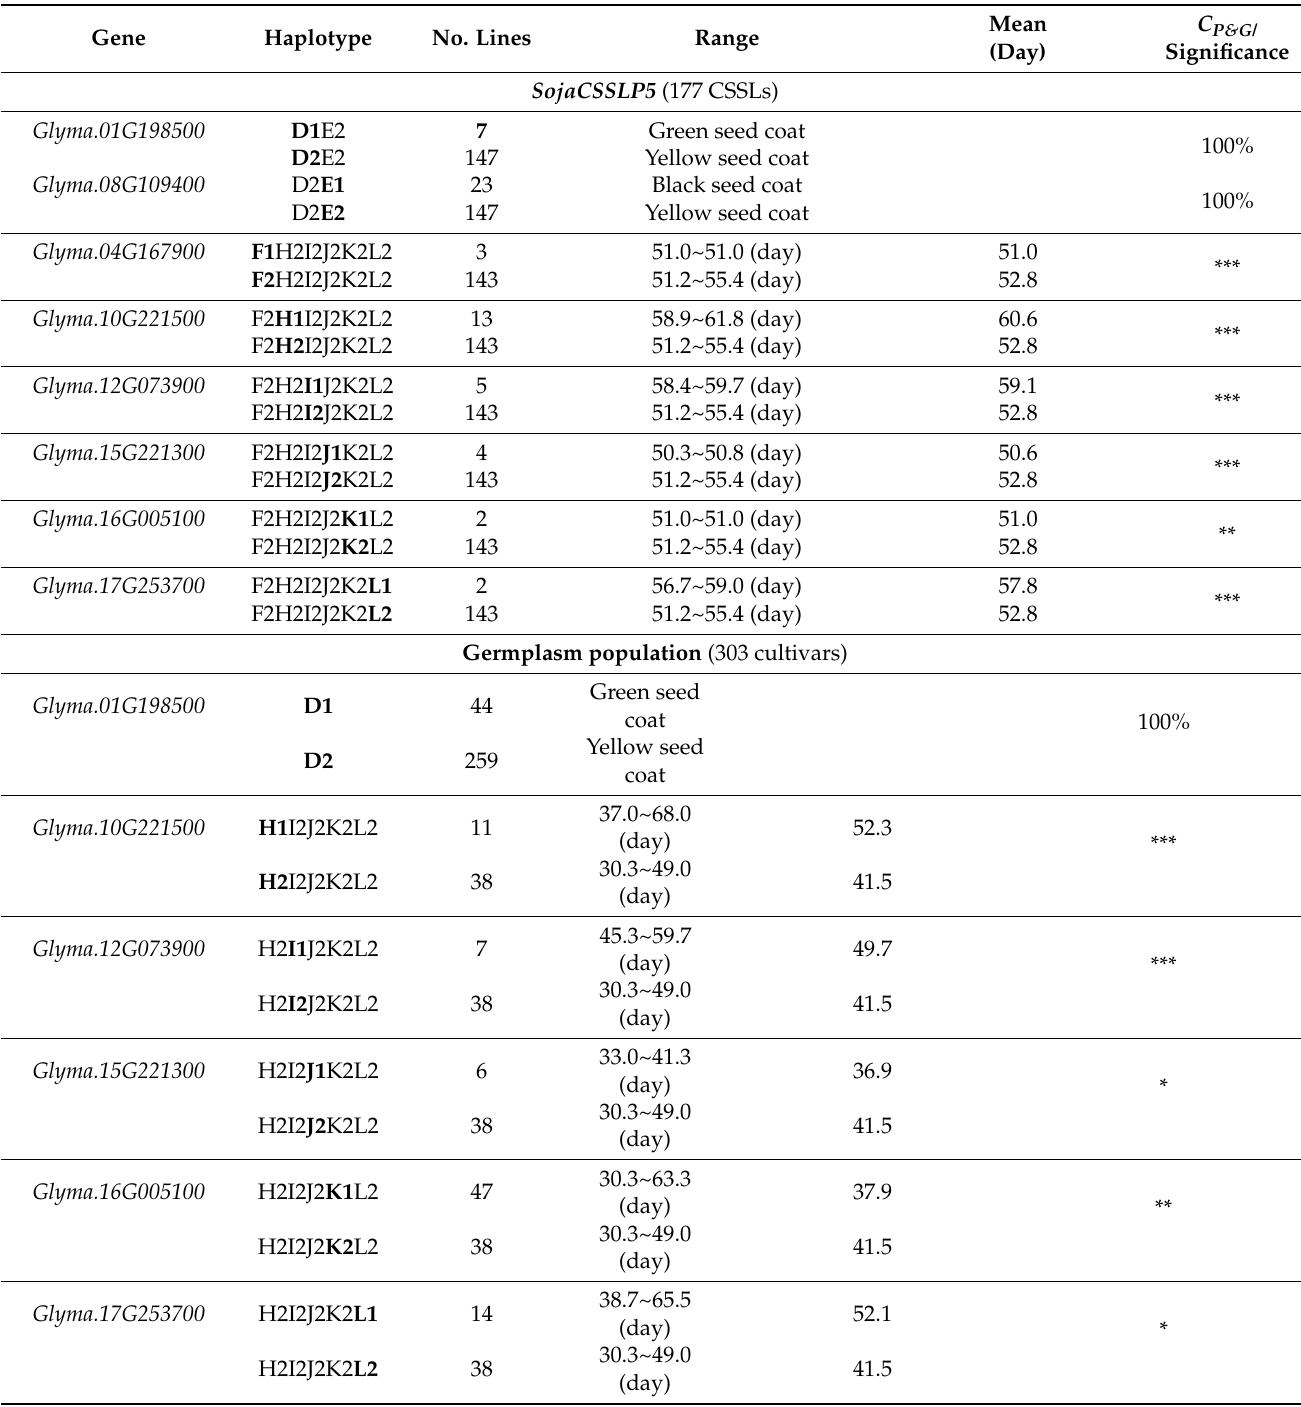
Table 5. The effects of wild versus cultivated gene-alleles/haplotypes in SojaCSSLP5 and germplasm accessions. Gene